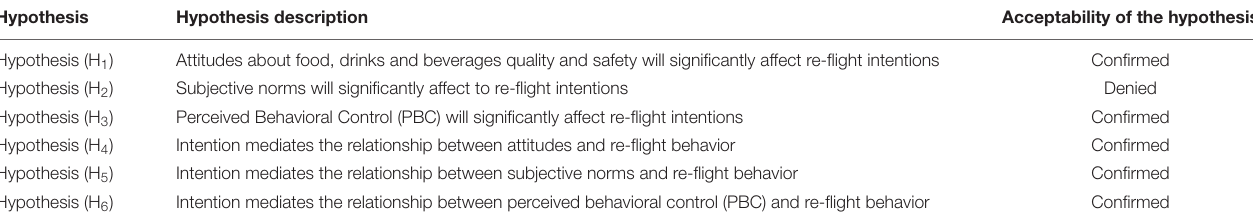
TABLE 4 | Acceptability of the hypothesis. Hypothesis Hypothesis description Acceptability of the